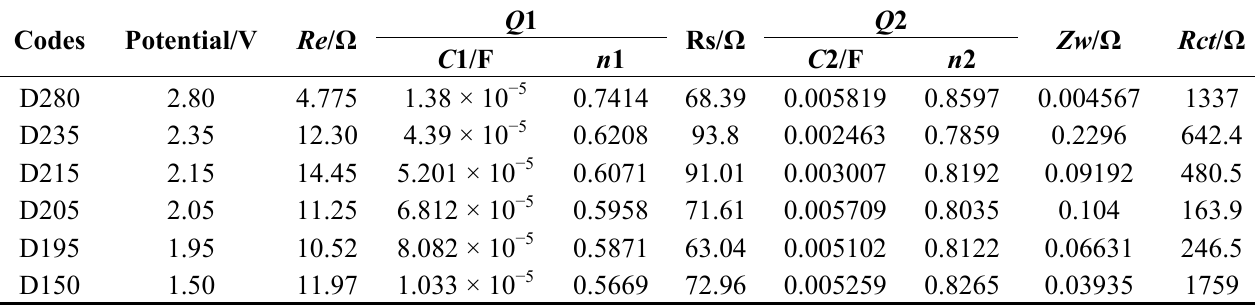
Table 3. Fitted values of the various elements in the equivalent circuit at different discharge/charge